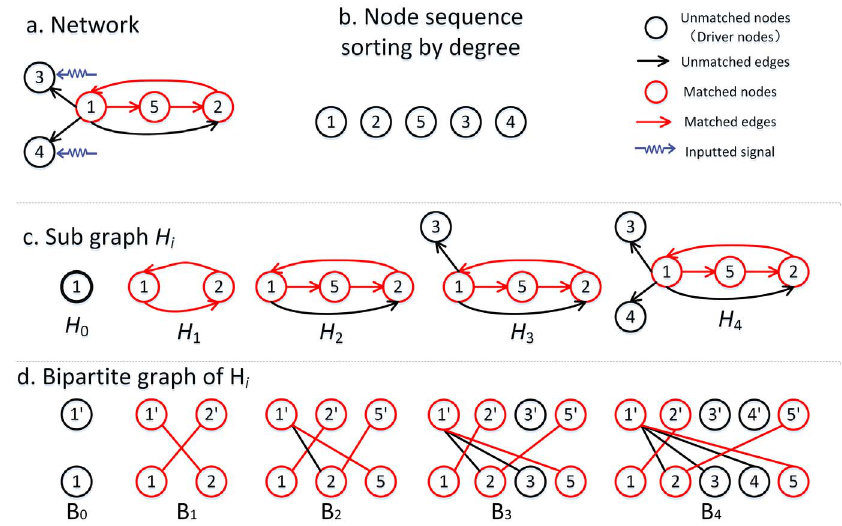
Figure 1. Illustration of the preferential matching algorithm process. We rank all of the nodes in descending order by degree, and the driver nodes are nodes v 3 and v 4 that are the last two of the sequence.